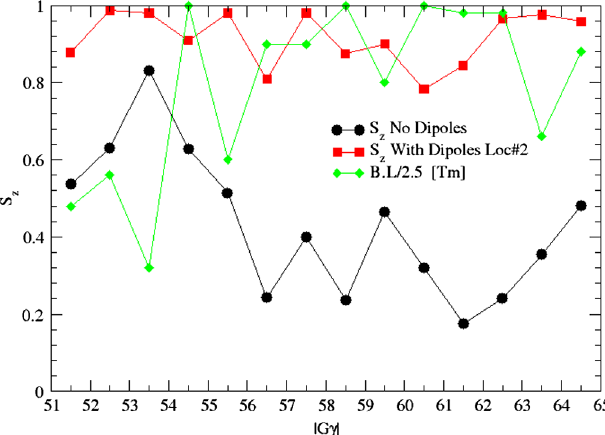
FIG. 7. The stable spin direction at the exit of the AtR line as a function of half integer j G γ j values. The black circles correspond to the S values when the three dipoles at the location ♯ 2 , shown z in Fig. 2 as red rectangles, are set to zero and the red squares when the set of three dipoles are excited. The green diamonds is R B · d l = 2 . 5 at the location ♯ 2 . the integrated dipole field